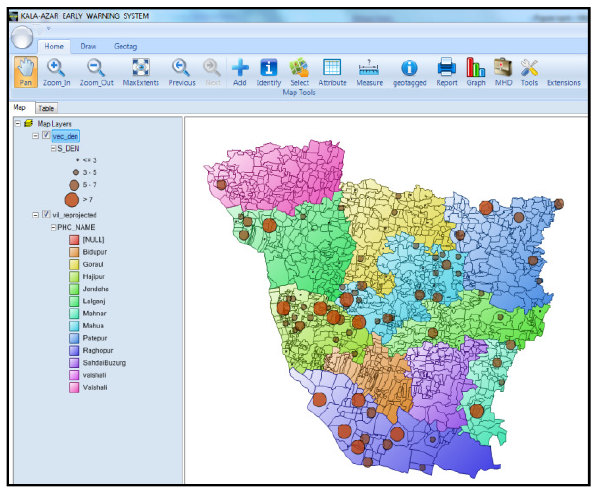
Fig. 8 Main Viewer of Software